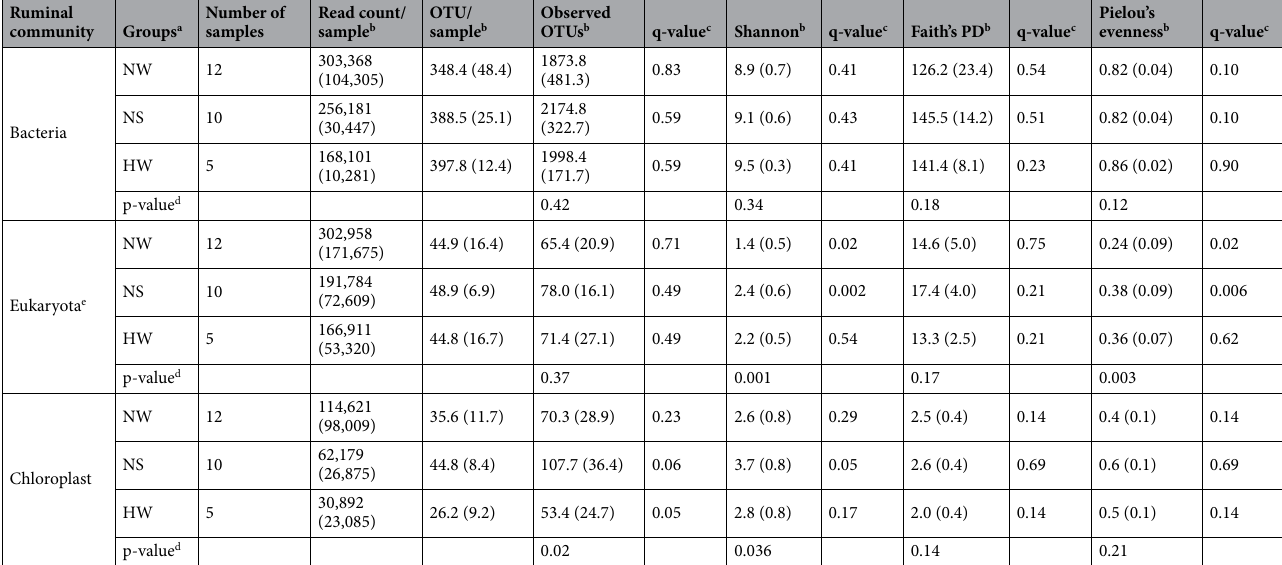
Table 1. Number of read counts, OTUs, and results of alpha-diversity metrics in the ruminal microbial and chloroplast composition of sika deer summarized by season and location. a NW, Nagano winter; NS, Nagano spring; HW, Hokkaido winter. b () indicates standard deviation. c q-values for each pair were calculated by pairwise Kruskal–Wallis test. q-values in NW, NS, and HW show the statistics against HW, NW, and NS, respectively. d p-values for all groups were calculated by Kruskal–Wallis test. e Mitochondria and chloroplast taxa were excluded.